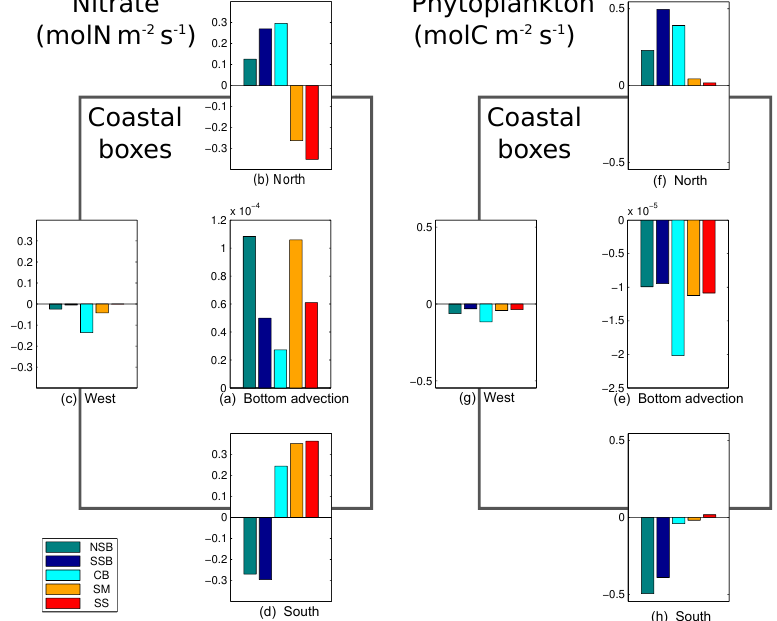
Figure 3. Annual mean of (a) vertical nitrate fluxes at the bottom of the coastal boxes and (b–d) lateral fluxes at the (b) northern, (c) western and (d) southern boundaries (molNm − 2 s − 1 ) ; annual mean of (e) vertical phytoplankton fluxes at the bottom of the coastal boxes and (f–h) lateral fluxes at the (f) northern, (g) western and (h) southern boundaries (mol Cm − 2 s − 1 ) . Vertical and lateral fluxes are defined as positive inward and upward. Note that the fluxes due to vertical diffusion are 1 order of magnitude lower compared to advection in the coastal boxes. Each colour corresponds to a box (see legend): northern Saharan Bank (NSB), southern Saharan Bank (SSB), Cape Blanc area (CB), Senegalo-Mauritanian region (SM) and southern Senegal region